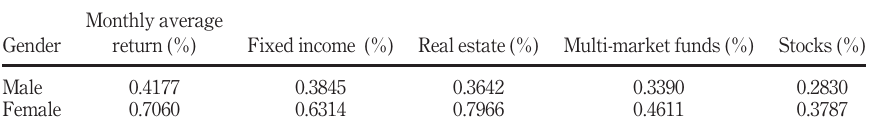
Table 2. Monthly